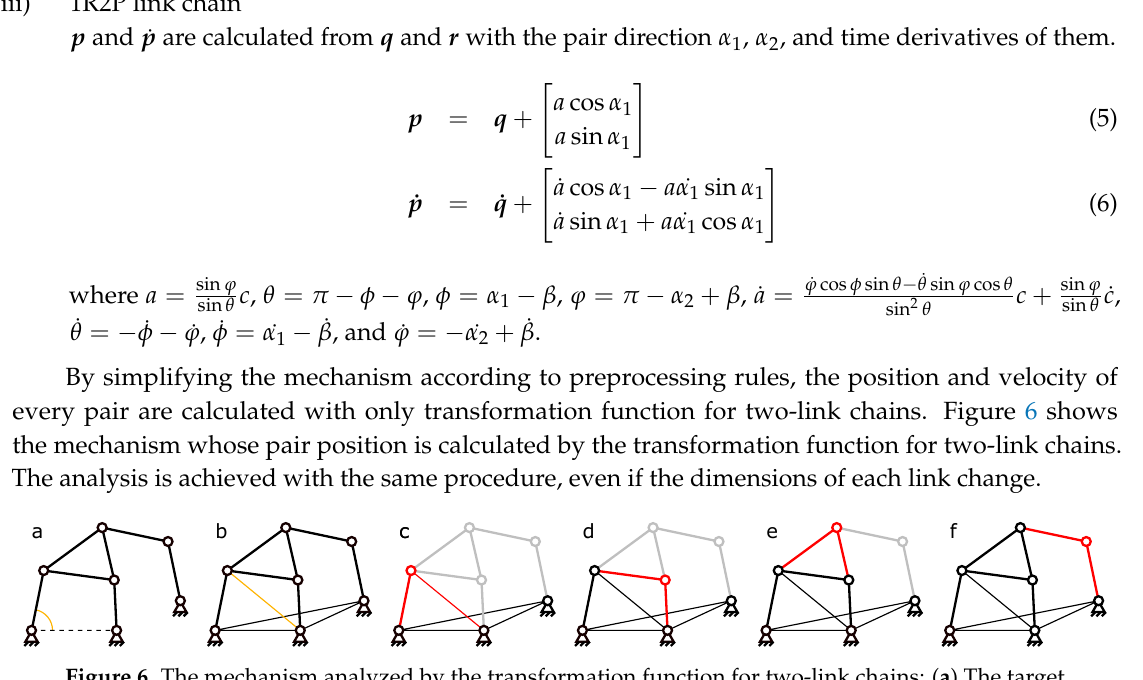
Figure 6. The mechanism analyzed by the transformation function for two-link chains: ( a ) The target mechanism ( b ) The active pair is rewritten as a new link. ( c – f ) The position of pair(red) is calculated by the transformation function for two-link